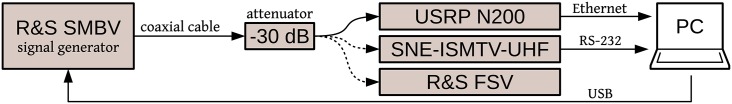
A diagram of our experimental setup.Coaxial cable with the attached attenuator was manually moved between devices. R&S FSV signal analyzer was used in power measurement mode to measure exact signal attenuation.